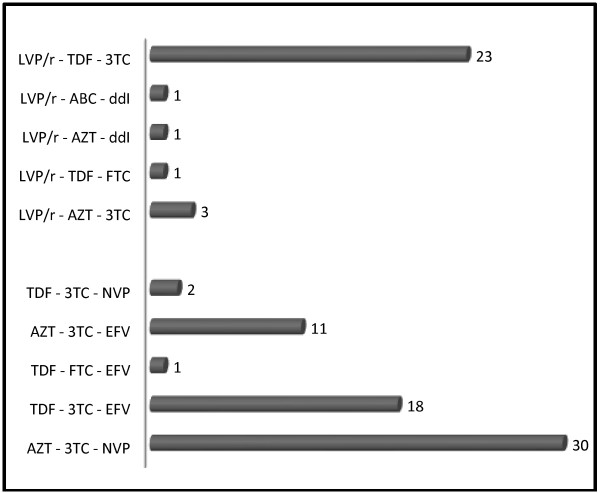
Different therapeutic regimens the 91 ART-receiving subjects were placed on: up are represented second line regimens and down the first line ones and the numbers refer to the number of subjects on each regimen.